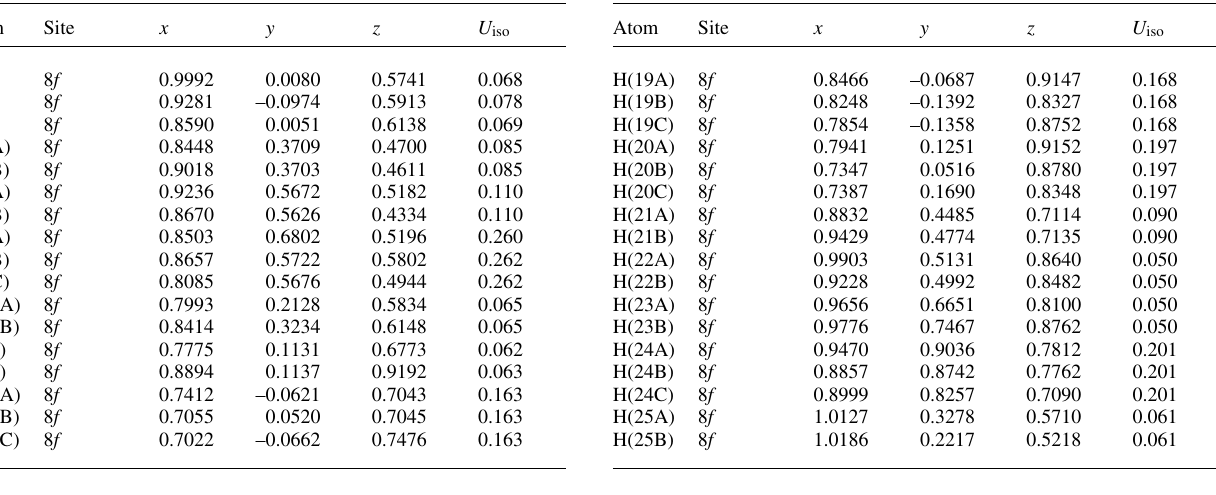
Table 2. Atomic coordinates and displacement parameters (in Å 2 )